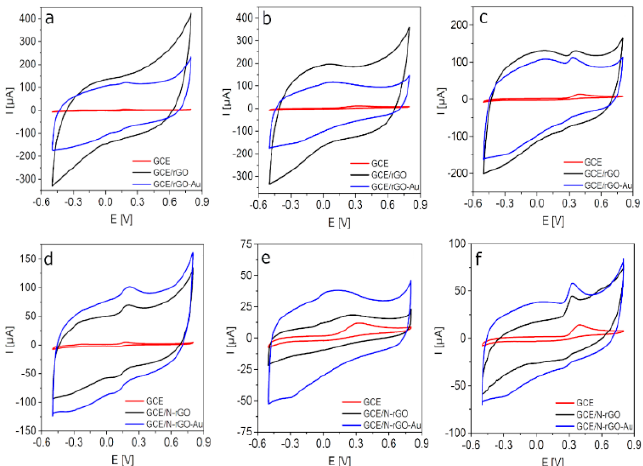
Figure 2. CVs recorded on ( a − c ) GCE, GCE/rGO, GCE/rGO-Au and ( d − f ) GCE, GCE/N-rGO, and N-rGO-Au electrodes in 0.1 M PBS (pH 7.4) containing ( a , d ) 100 µ M of DA, ( b , e ) 300 µ M of AA, and ( c , f ) GCE/N-rGO-Au electrodes in 0.1 M PBS (pH 7.4) containing ( a , d ) 100 µM of DA, ( b , e ) 300 µM of AA, 300 µ M of and ( c , f ) 300 µM of UA.